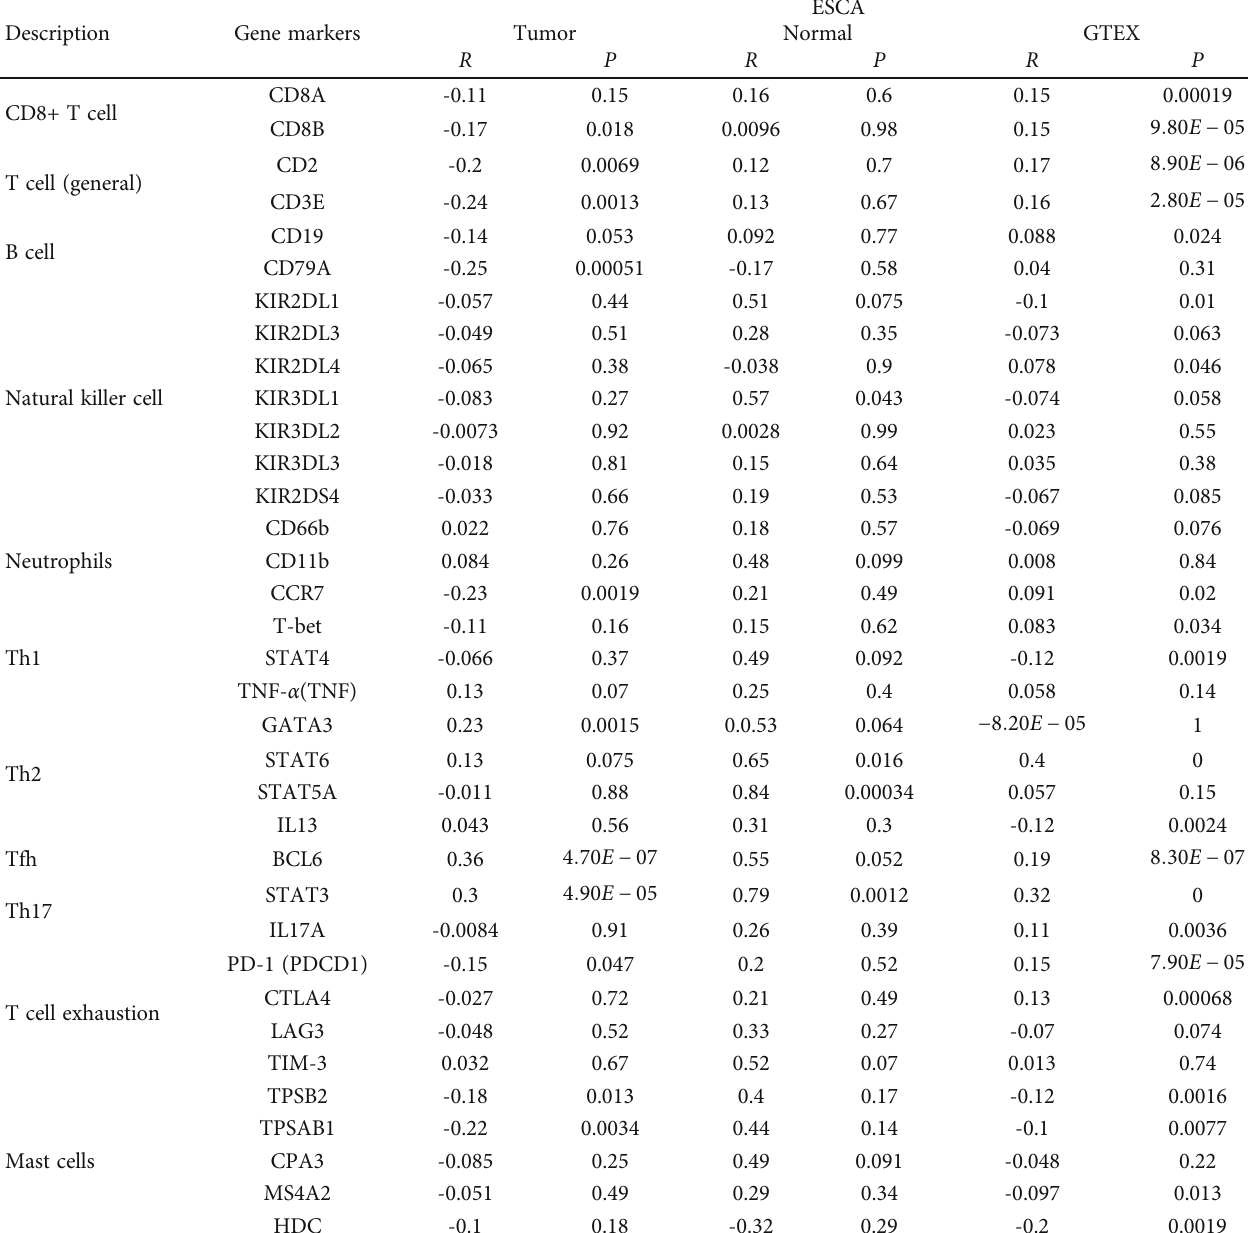
Table 1: The association of YY1 expression and immune markers in